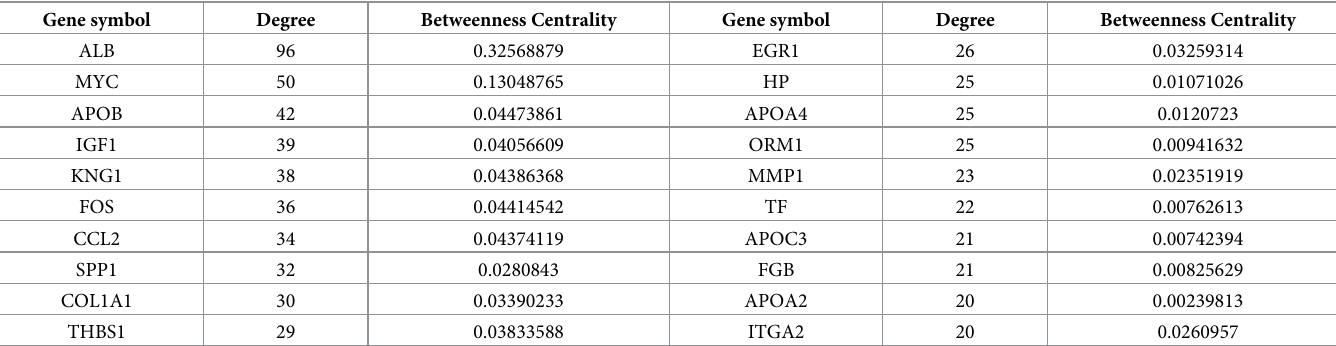
Table 1. Detailed information of the hub